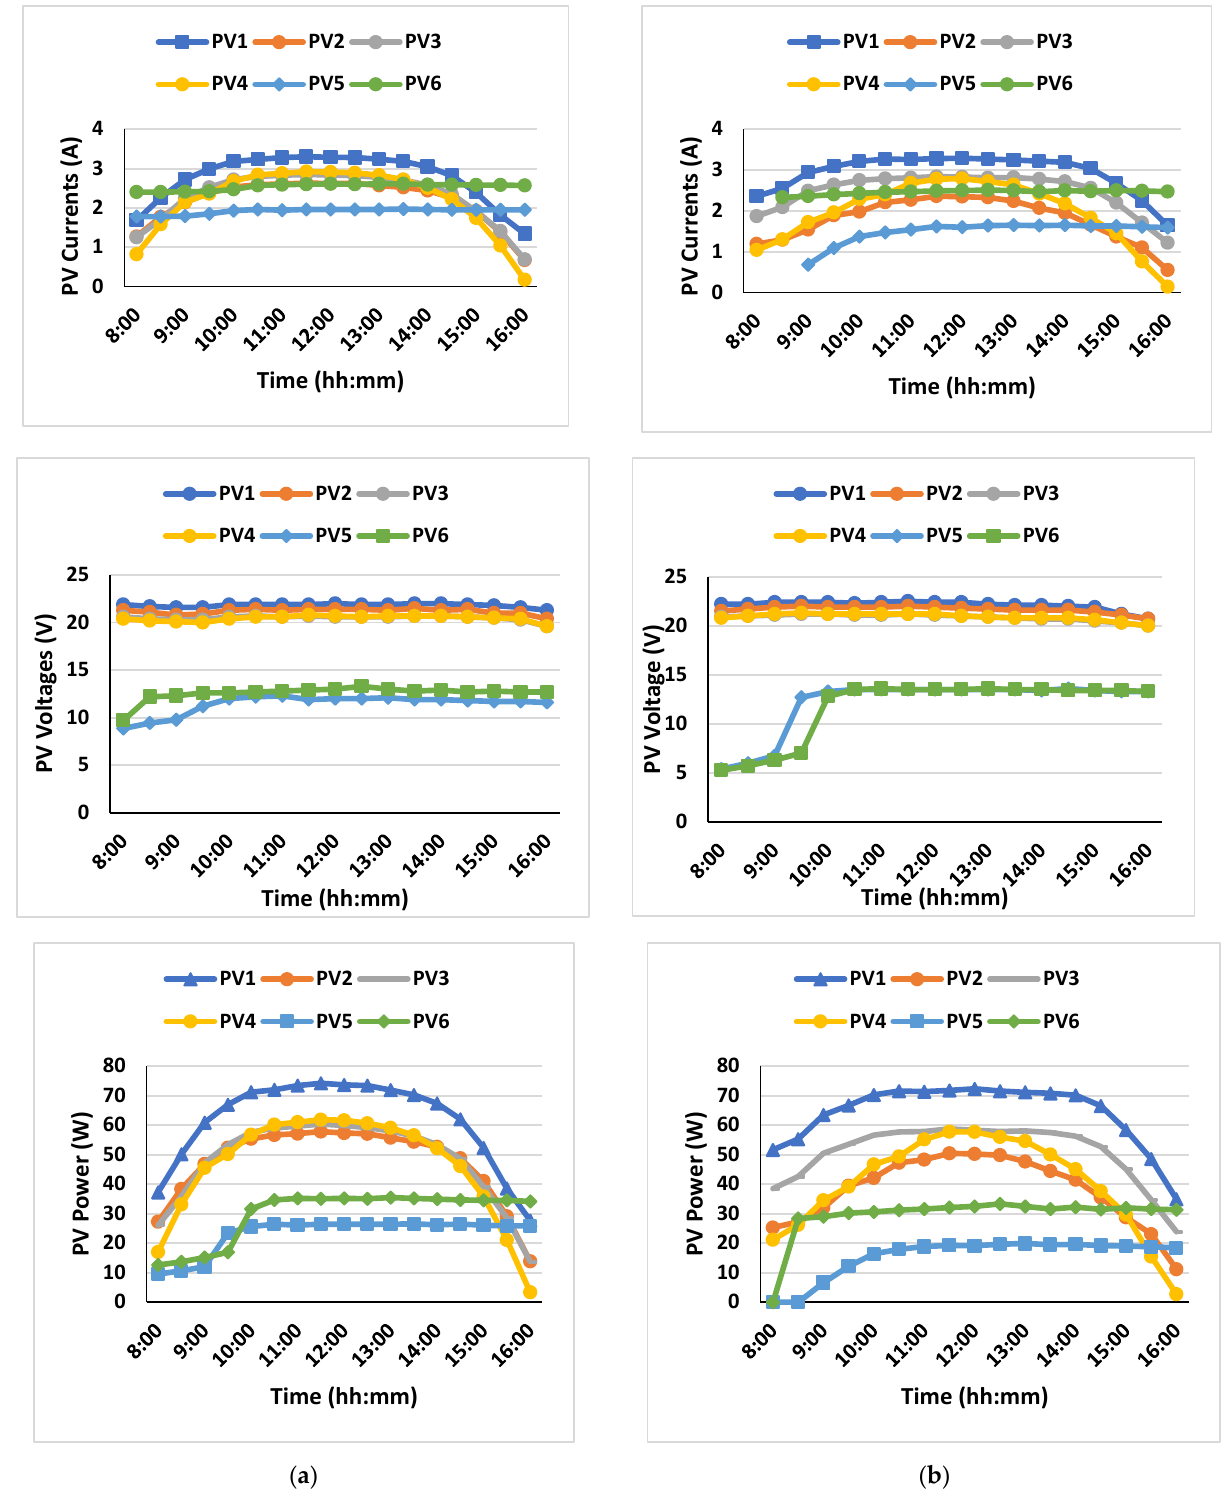
Figure 6. Comparison of electrical performance for ( a ) first day, and ( b ) after 35 days of the experiment.